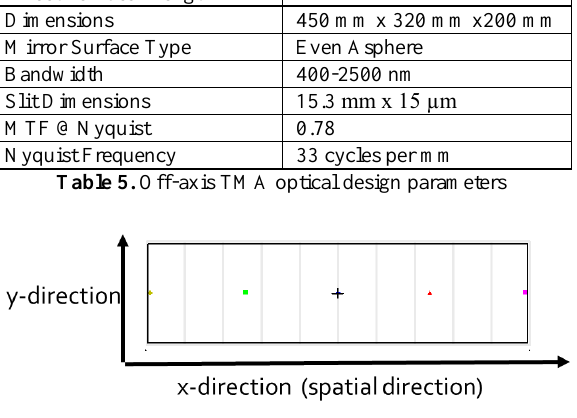
Figure 3. Footprint Diagram of the slit plane